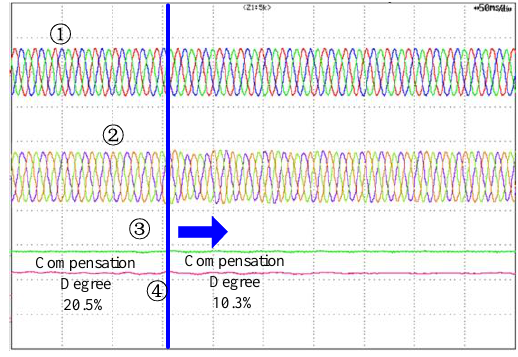
Figure 16. HFR damping for the VSC system.